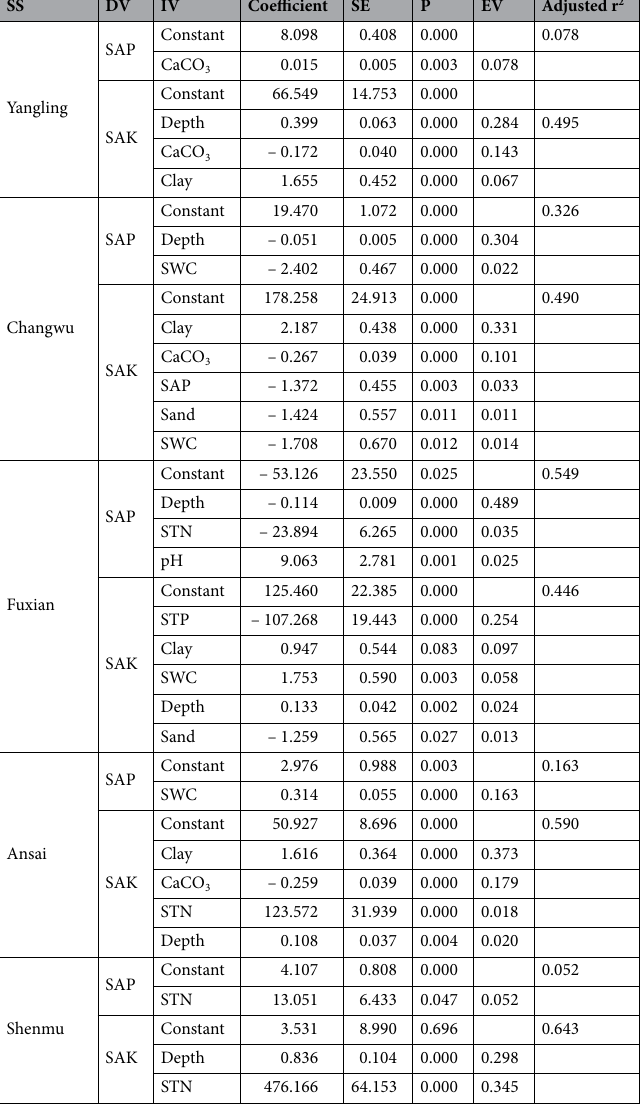
Table 3. Results obtained by multiple stepwise regression analyses between SAP, SAK, and the significantly correlated factors. SS sampling sites, DV dependent variable, IV independent variable, SE standard error, EV explained variation, P significance level.